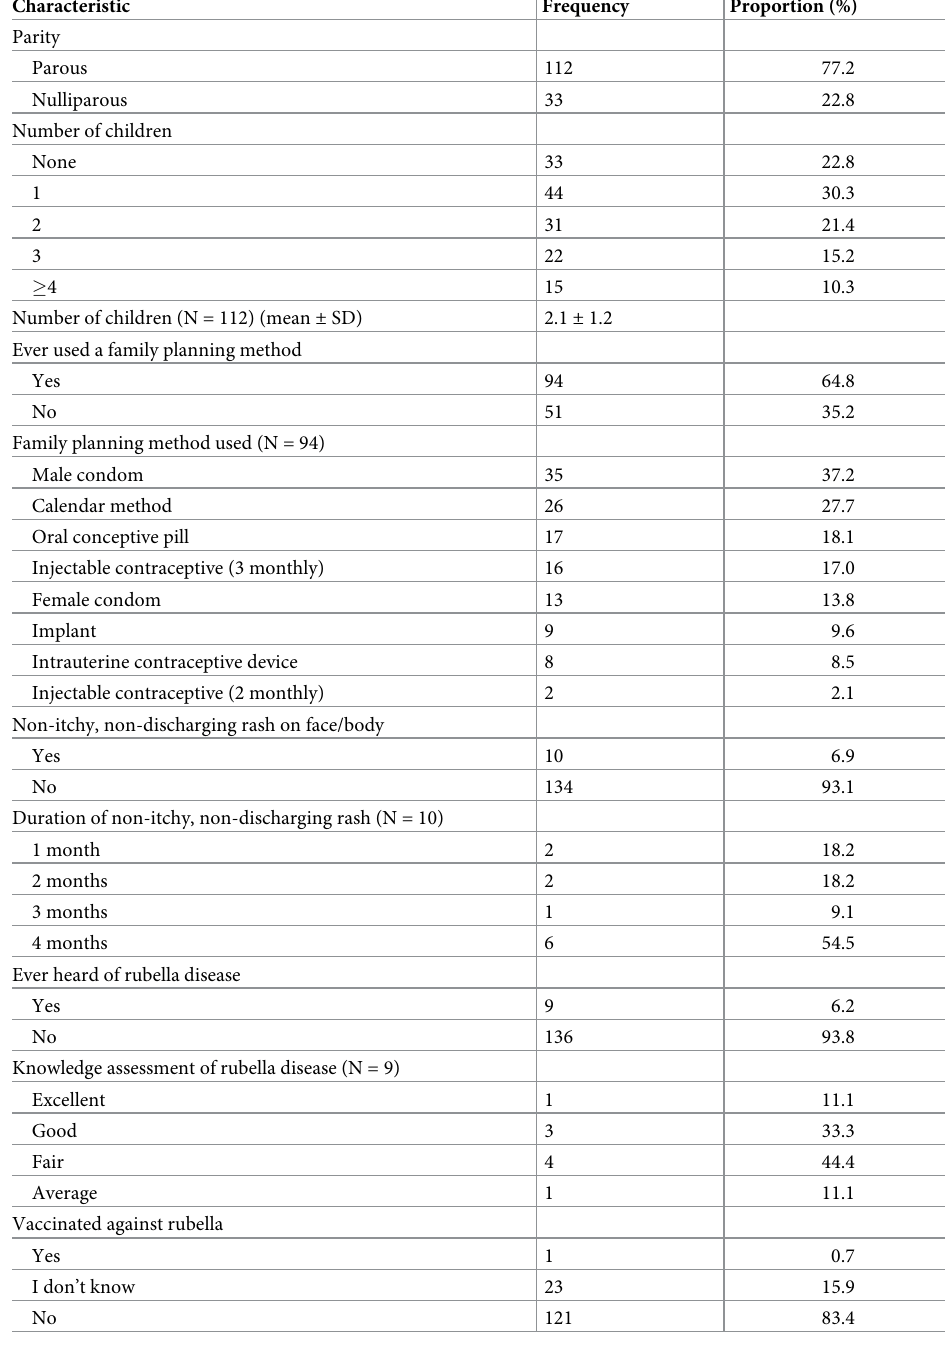
Table 2. General obstetric characteristics of study